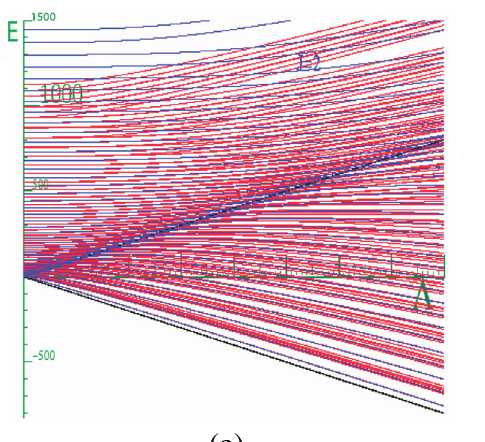
Figure 9. ( a ) Energy Spectrum for the two coupled rotor models super-imposed on the super-Mathieu for J = 2; ( b ) Energy Spectrum for the two coupled rotor models for J = 2 display